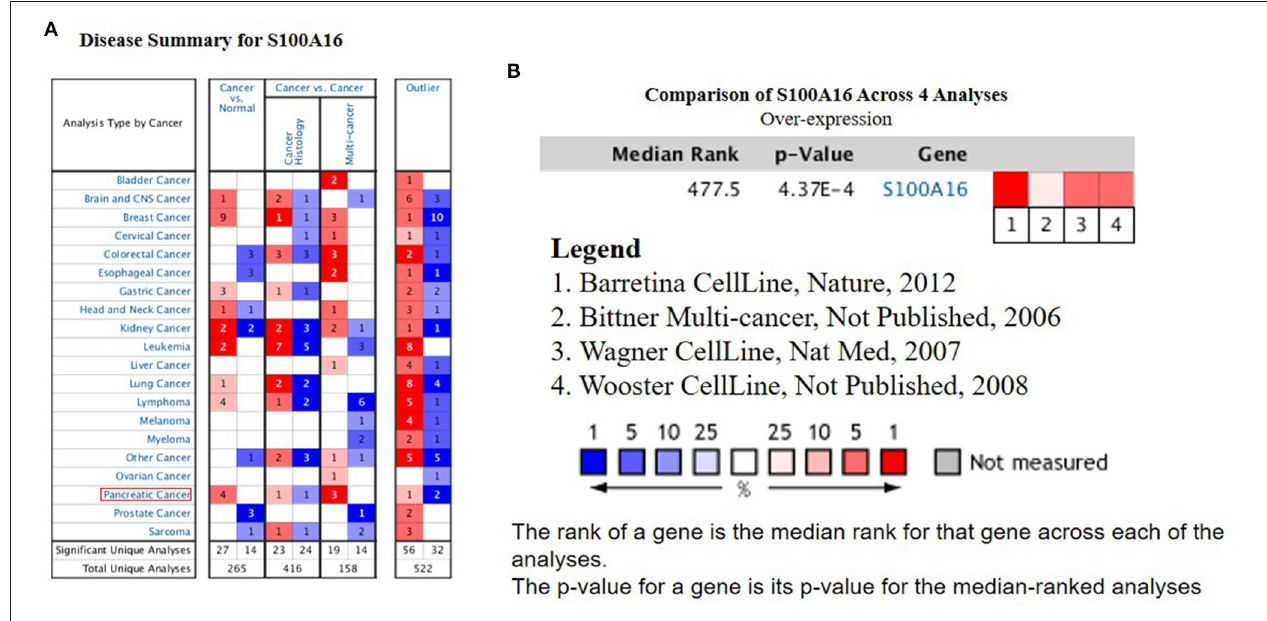
FIGURE 2 | High expression of S100A16 in PC based on Oncomine . (A) In PC, S100A16 was significantly upregulated in four studies. Blue represents low expression. Red represents high expression. The darker the color, the greater the significance. (B) Comparison of S100A16 expression across four analyses, and red means high expression. P < 0.01.The tumor type represented by each number is shown in Supplementary Figure 1